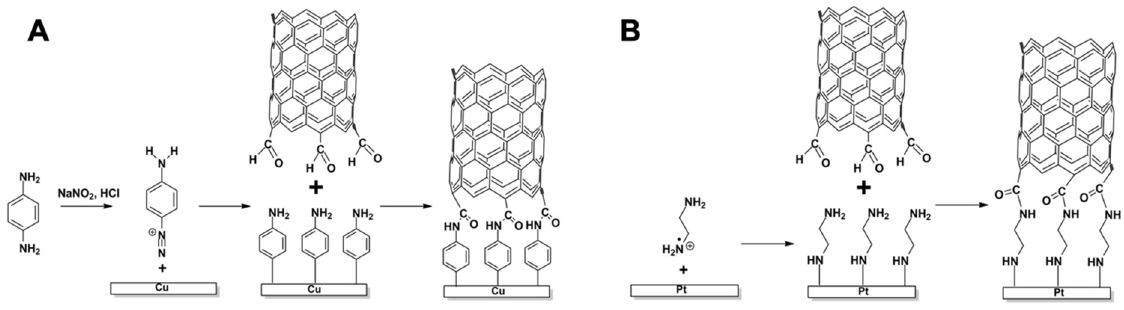
Figure 2. Proposed mechanism for the chemical bond formation between metals and open-ended CNTs. ( A ) In situ generation and attachment of an amine functional group to a Cu surface and subsequent bonding to a carboxylic acid functional group at the open end of a CNT. ( B ) Electrochemical attachment of ethylenediamine to a Pt surface and subsequent bonding of the amine end to the carboxylic acid at the open ends of the CNTs.